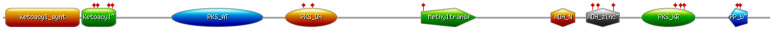
Schematic representation of the domain composition of the PKS estExt_Genewise1Plus.C_120511 (PI 173482) protein.Different domains are represented with different shapes and colors, with the relative name reported. Uncoiled regions are represented by a grey line. The identified SNPs that are affecting amino acids located in the predicted domains are reported as red marks.